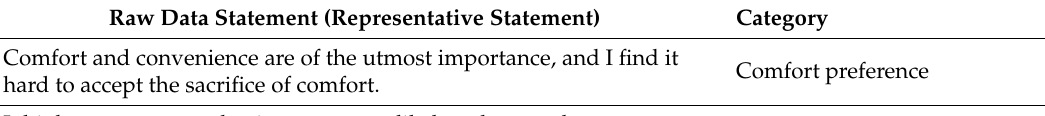
Table 3. Process and results of open